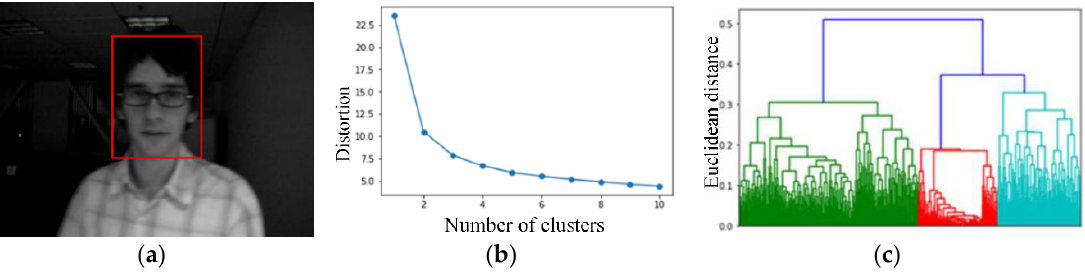
Figure 2. ( a ) Target image; ( b ) Using the Elbow method to check the validity of clusters; ( c ) Three clusters are also determined by HKC, consistent with the result in ( b ).